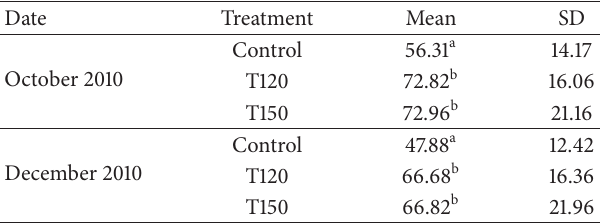
Table 3: 𝐻/𝐷 ratio mean of argan seedlings for October and December 2010. Values sharing the same letter within the same date are not significantly different at 5% by Scheff´e